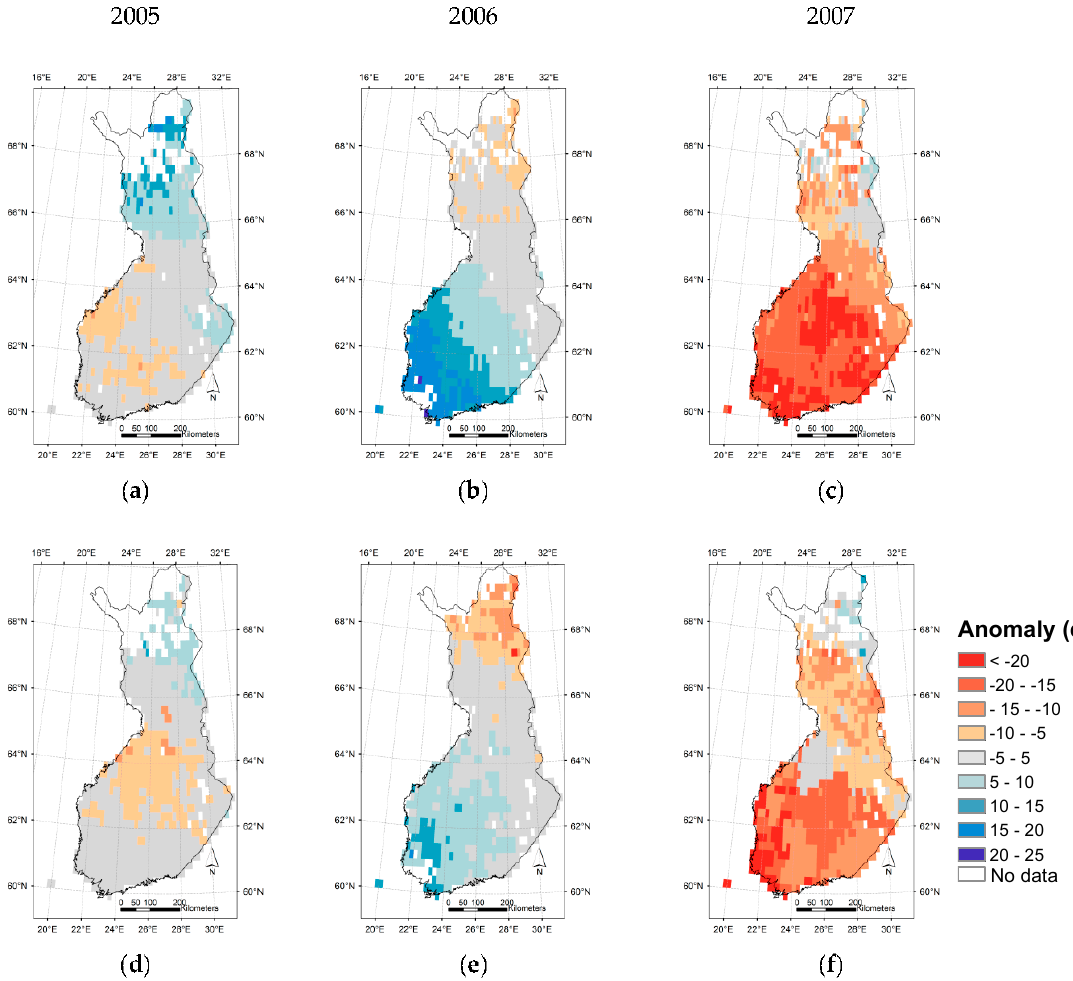
Figure 11. ( a – f ) Spatial distribution of yearly anomalies, the deviations (in days) from grid cell mean for 2003–2010, of start of season in evergreen needle-leaf forest. Upper panel: remote sensing estimate (ENF_SOS sat ). Lower panel: model-derived estimate (ENF_SOS mod ).